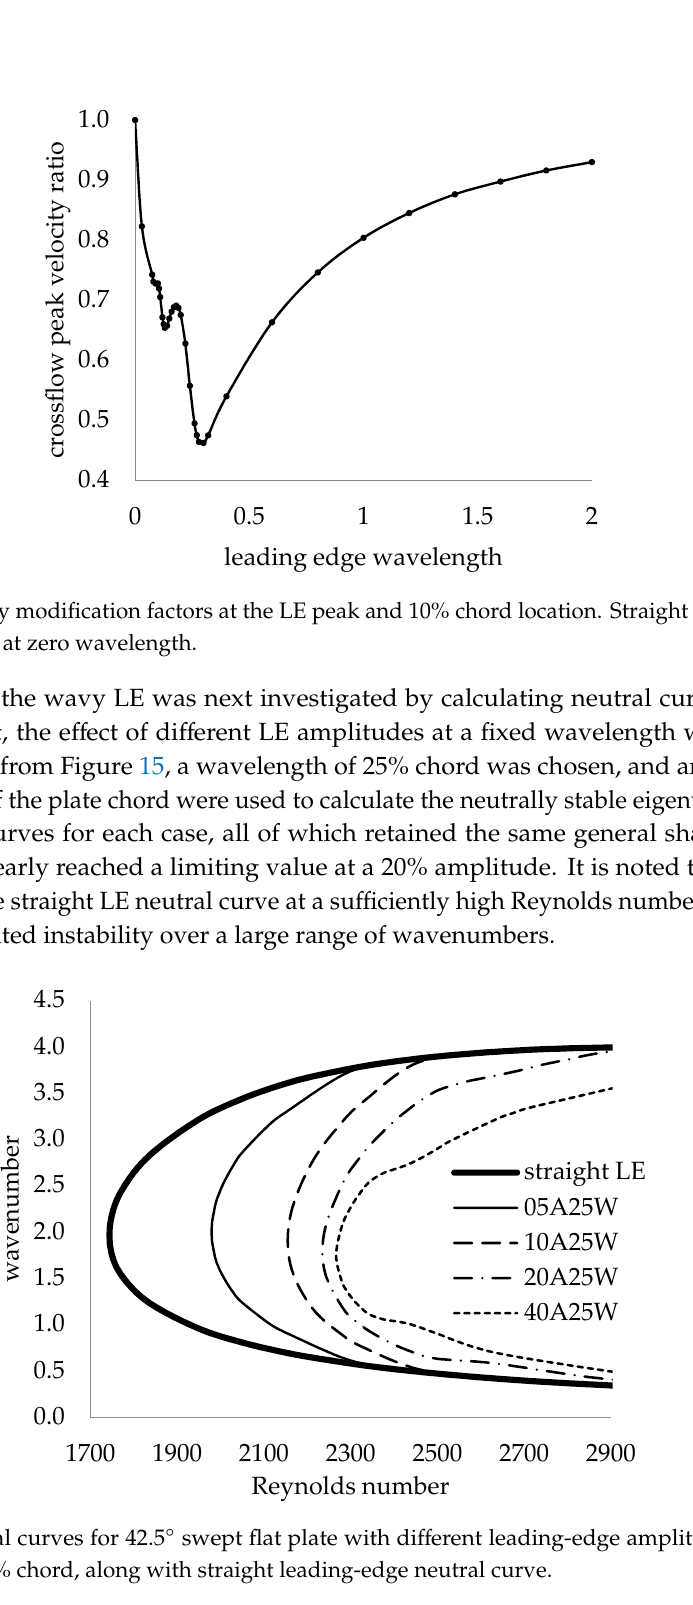
Figure 16. Neutral curves for 42.5° swept flat plate with different leading-edge amplitudes at fixed wavelength of 25% chord, along with straight leading-edge neutral curve.